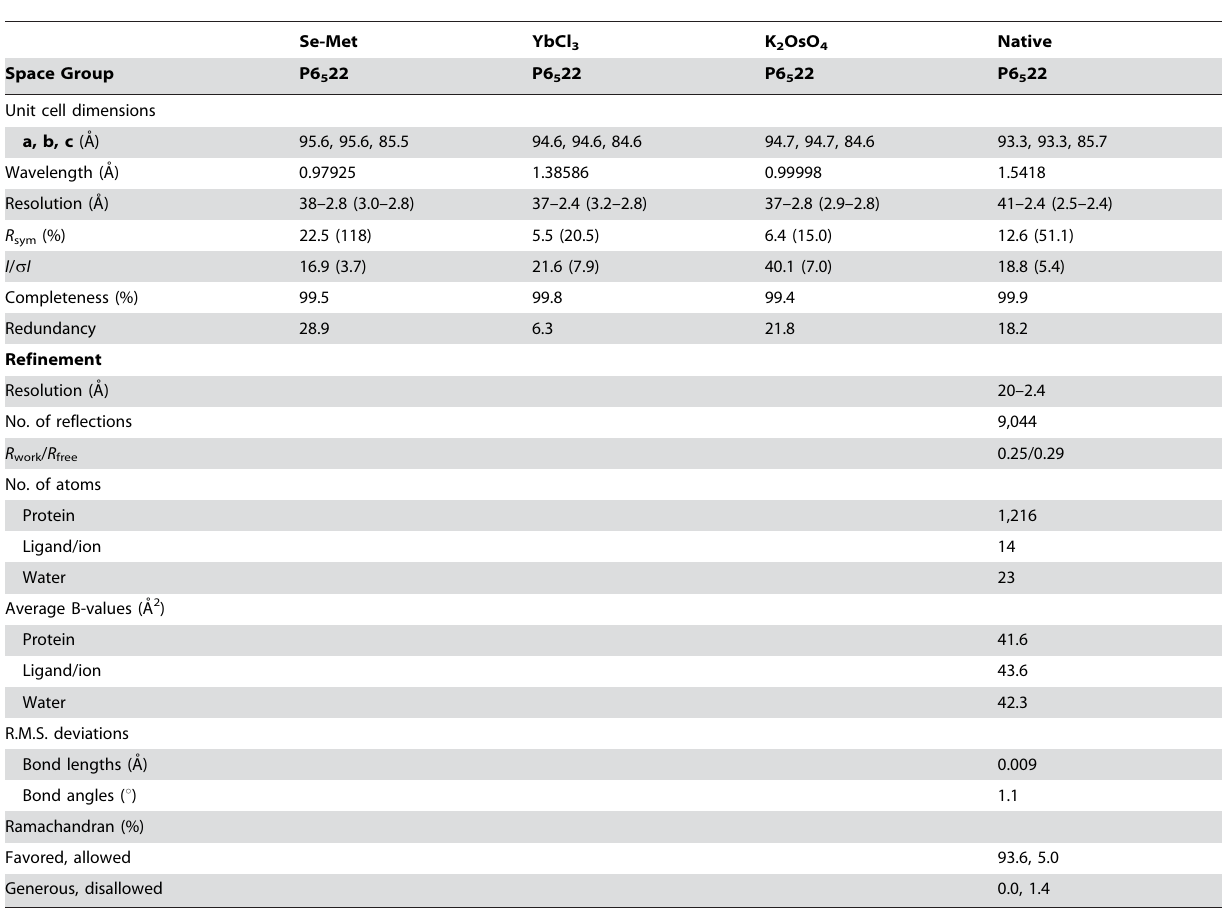
Table 1. X-ray data and structure refinement